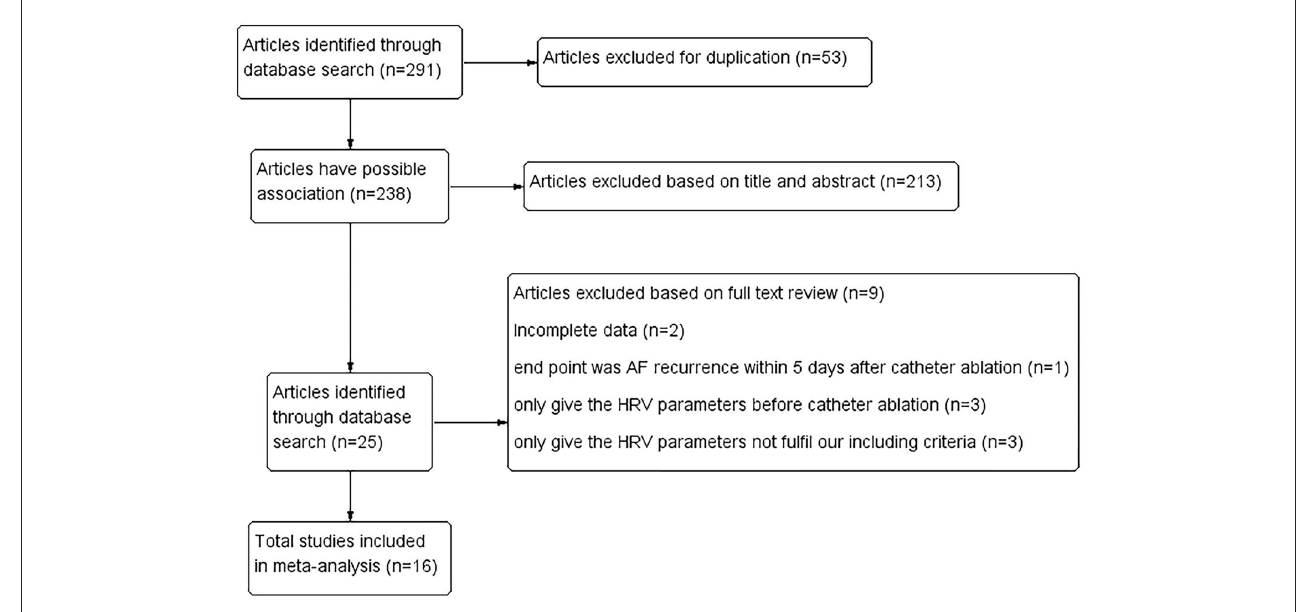
FIGURE1 Literature search and identification process.